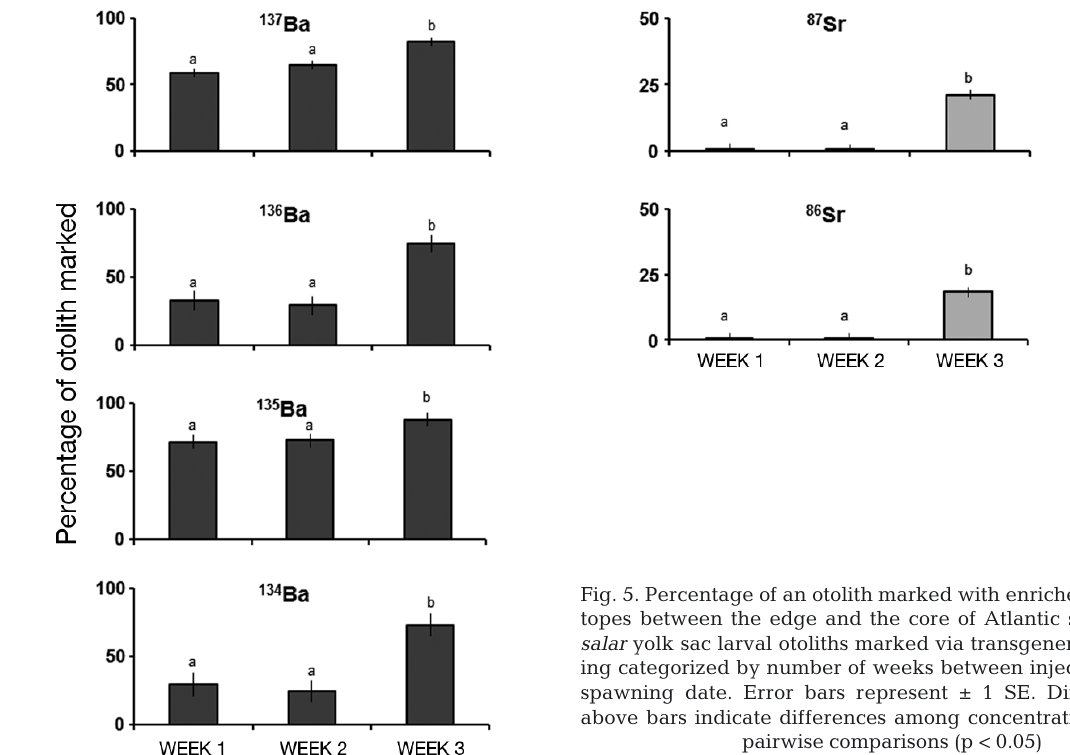
Fig. 5. Percentage of an otolith marked with enriched barium iso- topes between the edge and the core of Atlantic salmon Salmo salar yolk sac larval otoliths marked via transgenerational mark- ing categorized by number of weeks between injection date and spawning date. Error bars represent ± 1 SE. Different letters above bars indicate differences among concentrations based on pairwise comparisons (p <